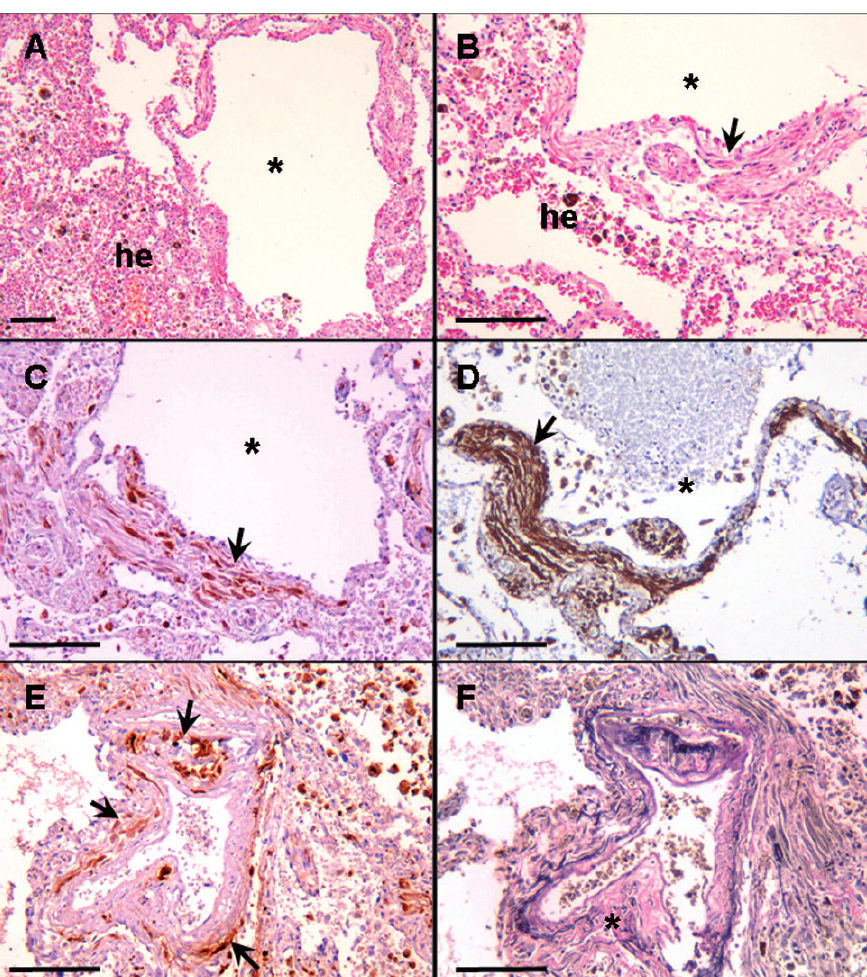
Figure 2 - Histological evaluation. Photomicrographs show pulmonary changes observed during the autopsy. A and B) Pulmonary tissue with LAM cysts (*) associated with alveolar hemorrhage (he). Note the smooth muscle tissue proliferation at the cyst wall (B, arrow). HMB-45 and alpha-smooth muscle actin-positive LAM cells at the cysts wall (arrows) are shown in C and D, respectively. E) HMB45- positive LAM cells within the small pulmonary artery wall (arrows). F) Disruption of the arterial elastic layer (*). The adjacent alveolar spaces indicate the presence of hemosiderin-laden macrophages (top right in E and F). A and B: H&E staining; C, D and E: immunohistochemistry; F: Verhoeff staining. Scale bars = 50